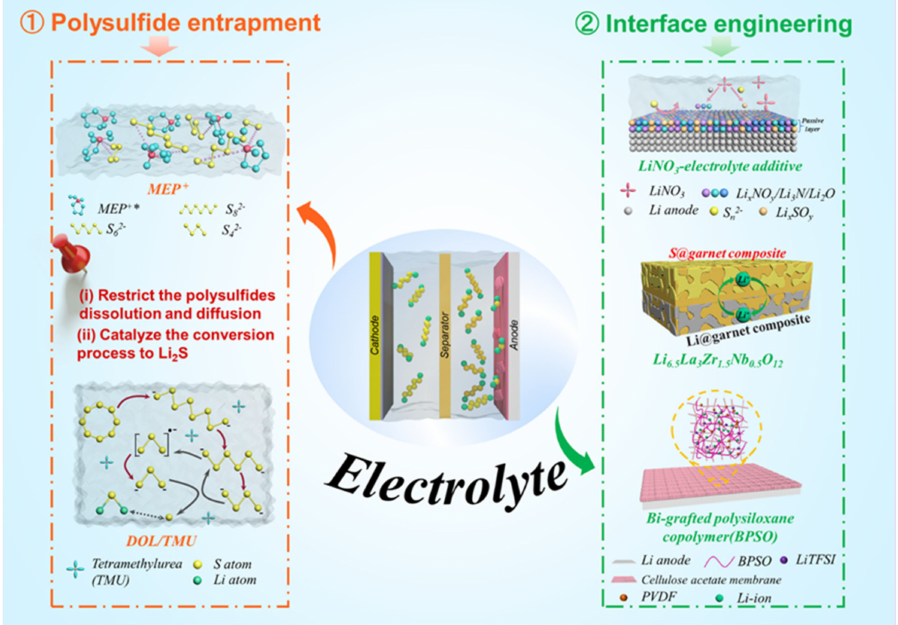
Figure 3. Strategies and perspectives to enable Li–S pouch cells under lean electrolyte conditions. ( 1 ) Regulate polysulfide species generated during the conversion process. ( 2 ) Engineering the interface between the electrolyte and the lithium metal